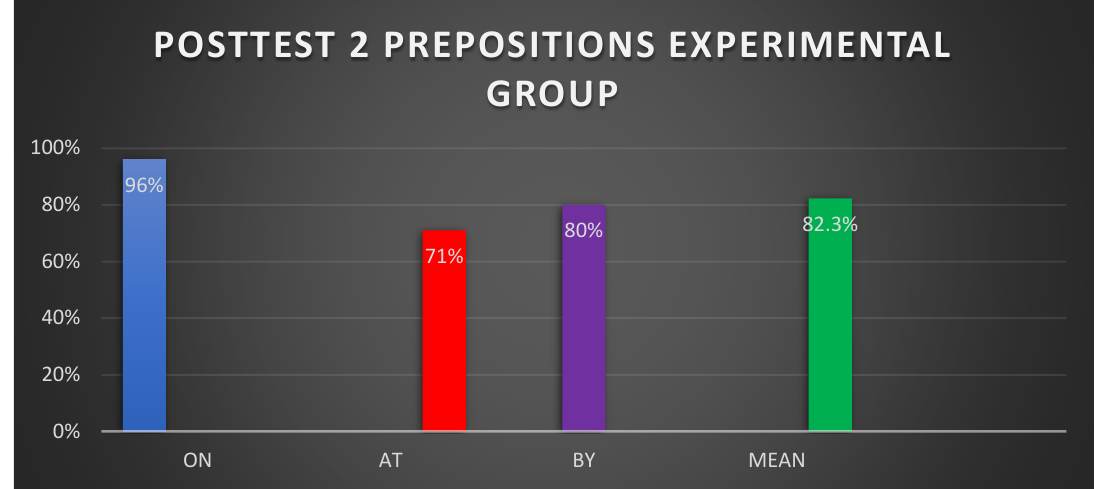
Figure 8. Posttest 2 experimental group prepositions and means.